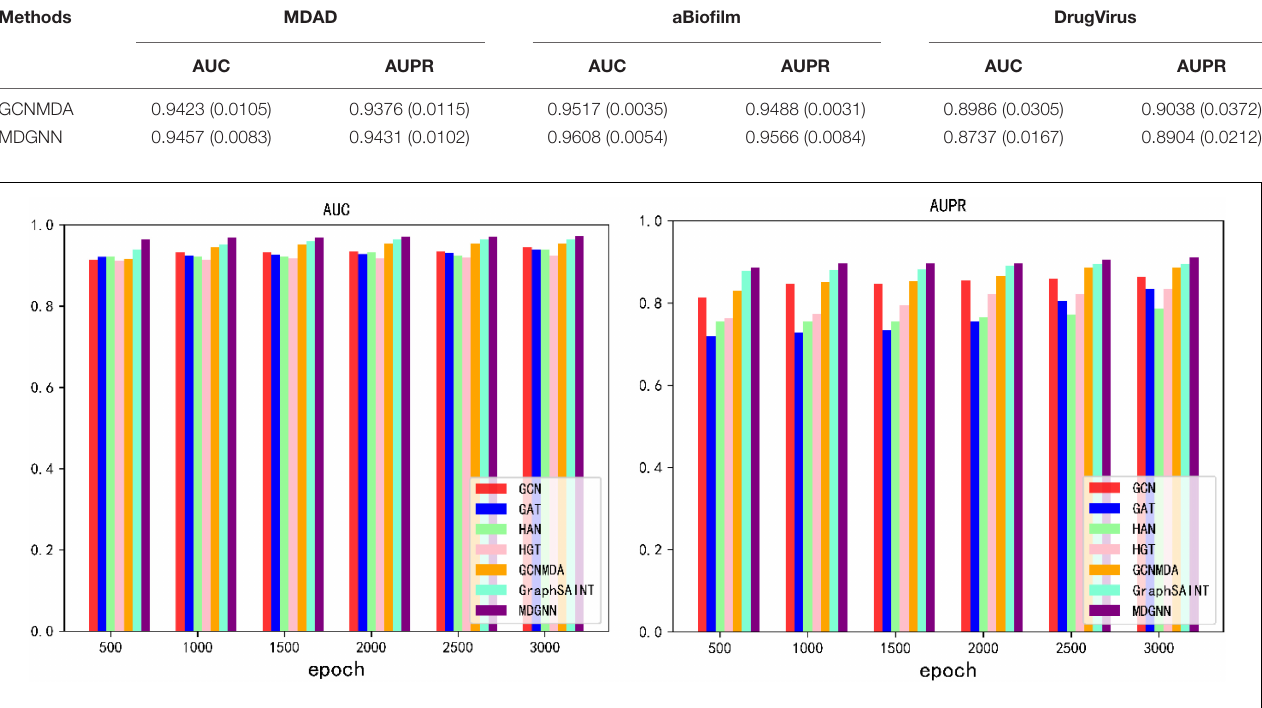
TABLE 4 | Compare the 5-fold crossover experimental results of MDGNN and GCNMDA on three small datasets (MDAD, aBiofilm, and DrugVirus). Methods